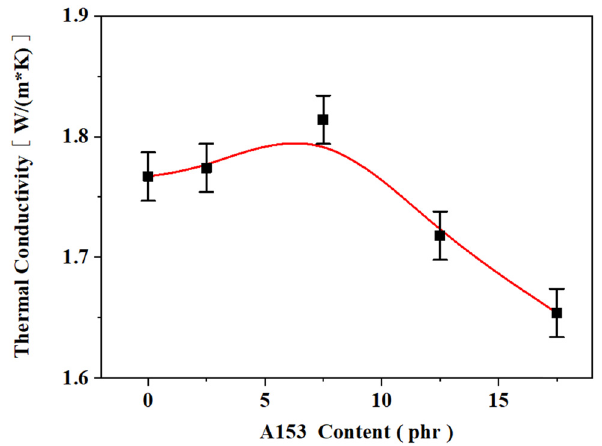
Figure 3: E ff ect of A153 content on thermal conductivity of PP composites.